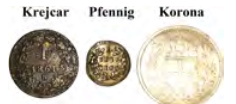
Figure 2. Third set of historical coins analyzed using activation analysis.